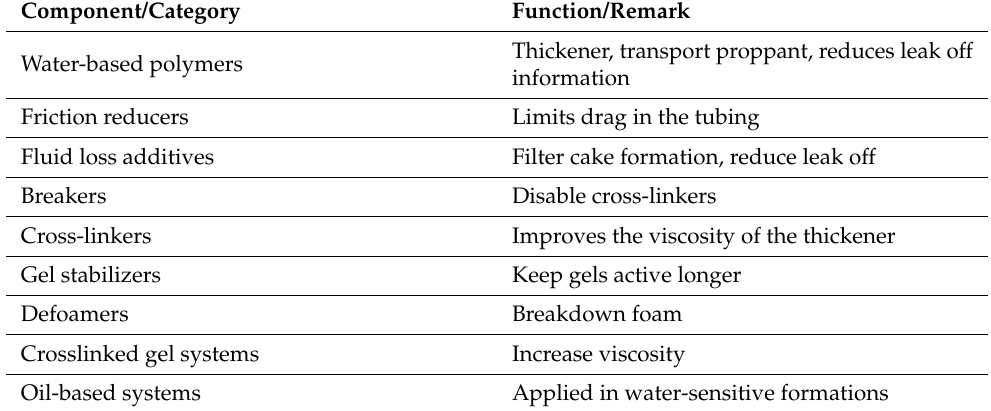
Table 1. Ingredients of hydrofrac